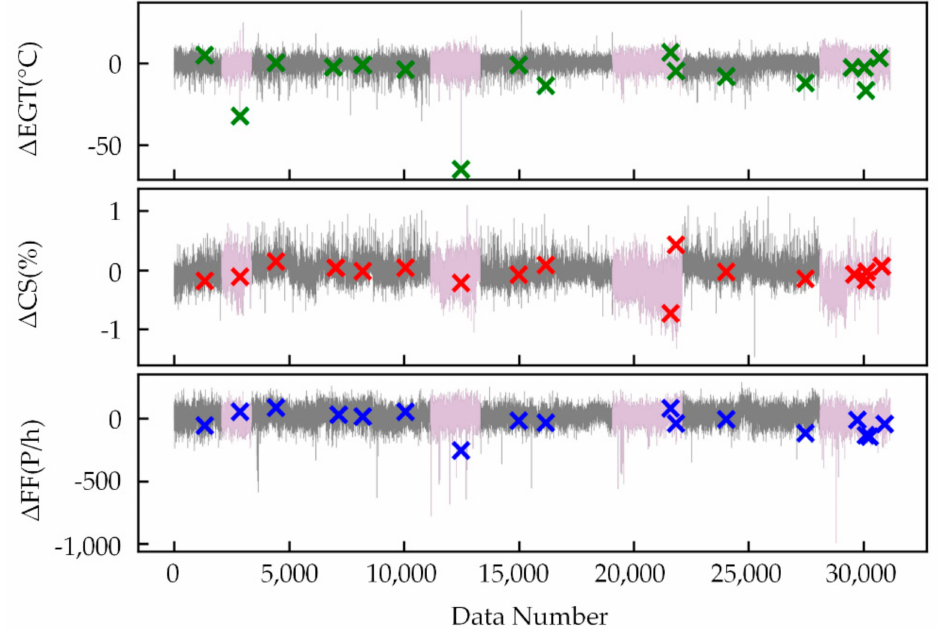
Figure 12. Feature extraction result without Loss WSCE and classifier.